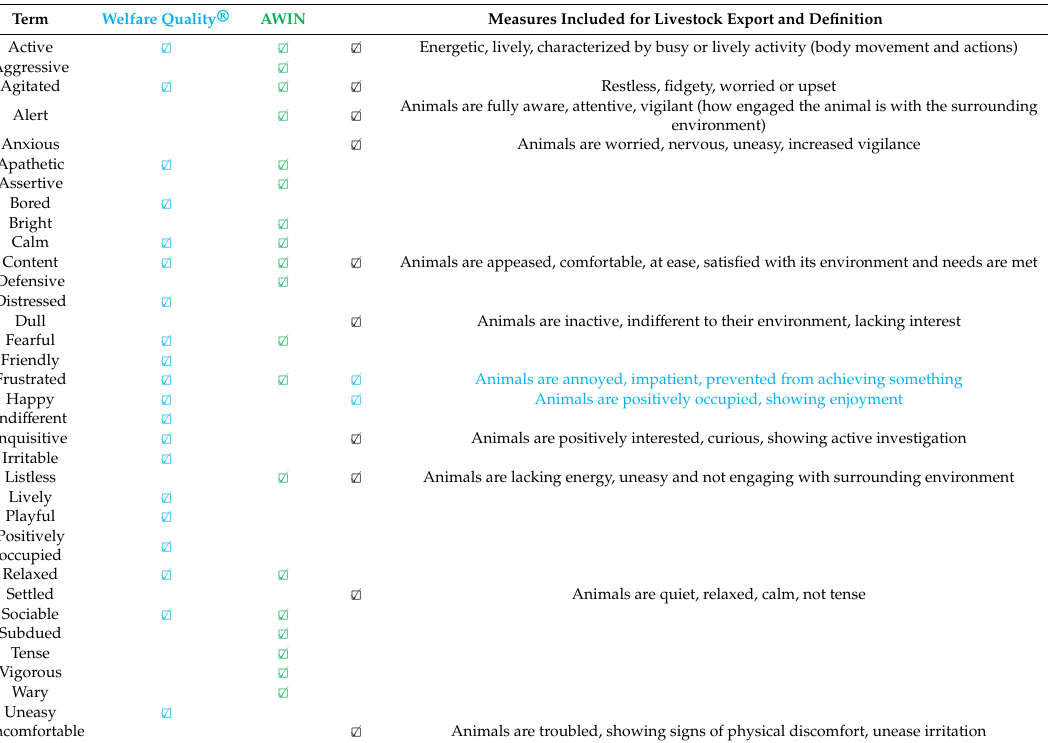
Table 2. Qualitative behavioural assessment terms used by existing protocols and proposed for the livestock export protocol. Colour indicates measures that are species specific, with blue indicating cattle only, green indicating sheep only, and black indicating measures that are applicable to both